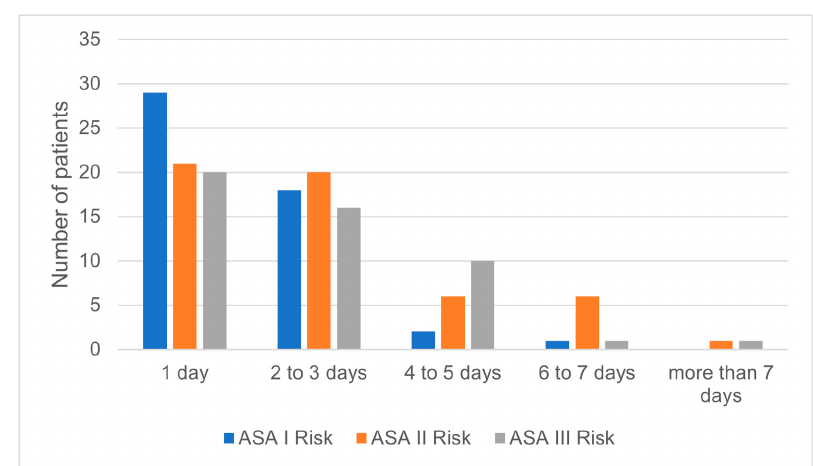
Figure 6. Correlation between days of hospitalization and ASA risk.